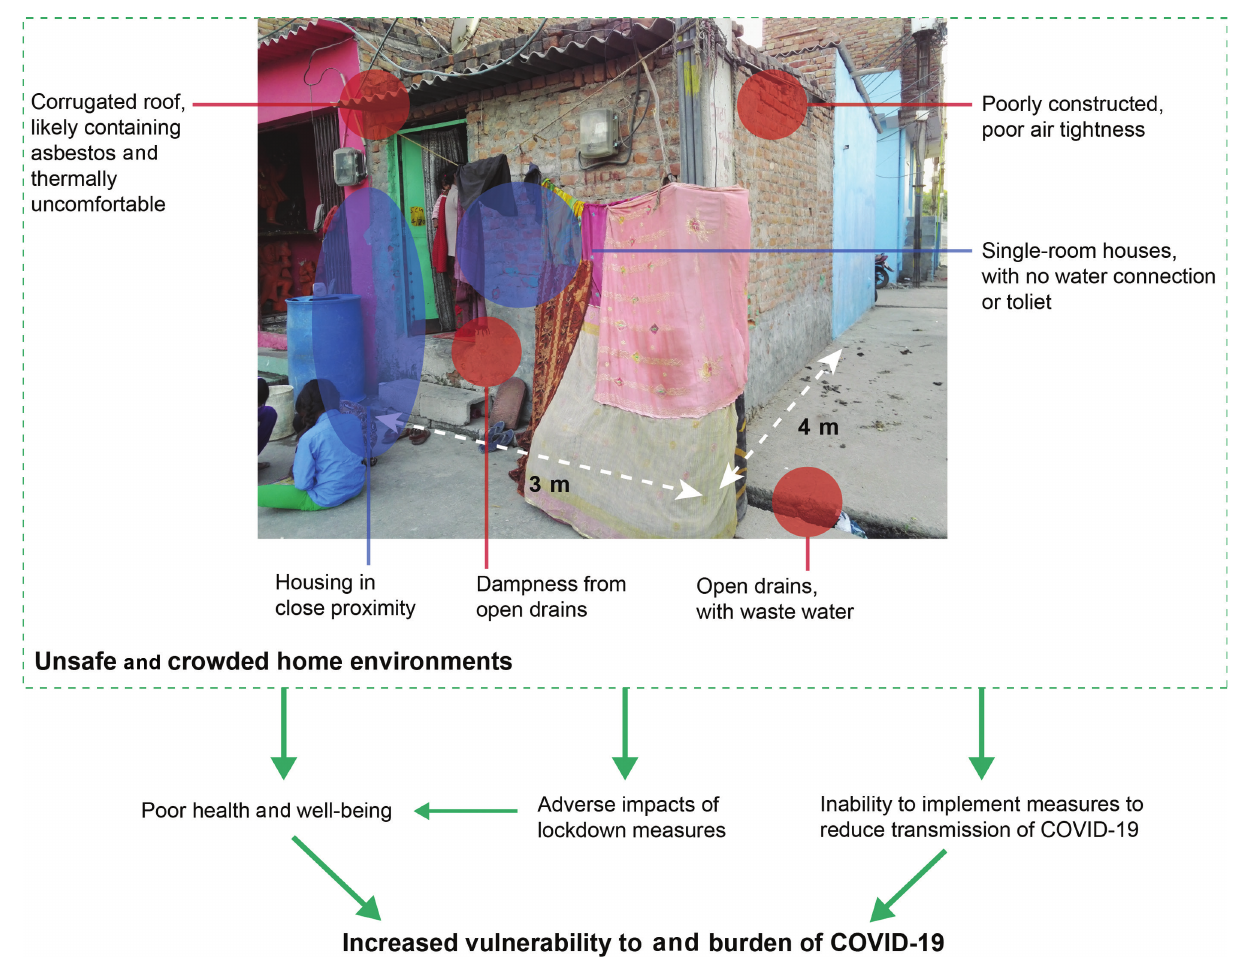
Connections between (non- exhaustive) unsafe and crowded homes environments and COVID-19 vulnerability and burden in informal